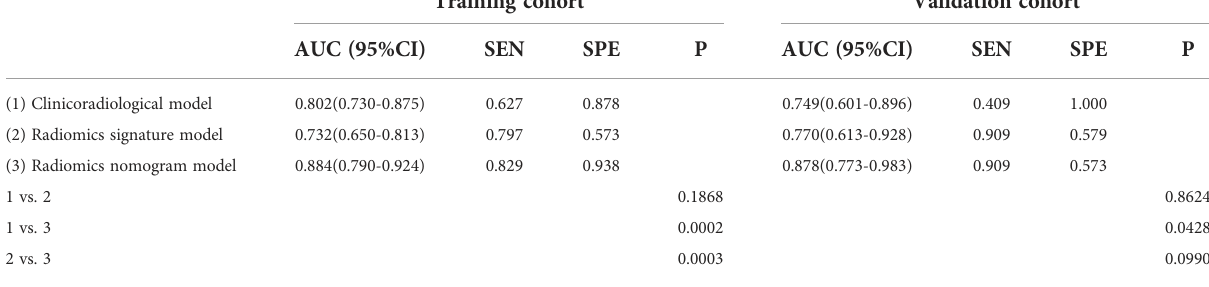
TABLE 2 Predictive performance of the three